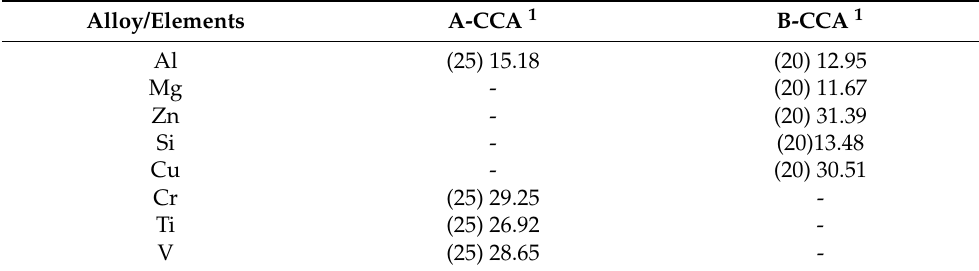
Table 1. Chemical composition of A-CCA and B-CCA.